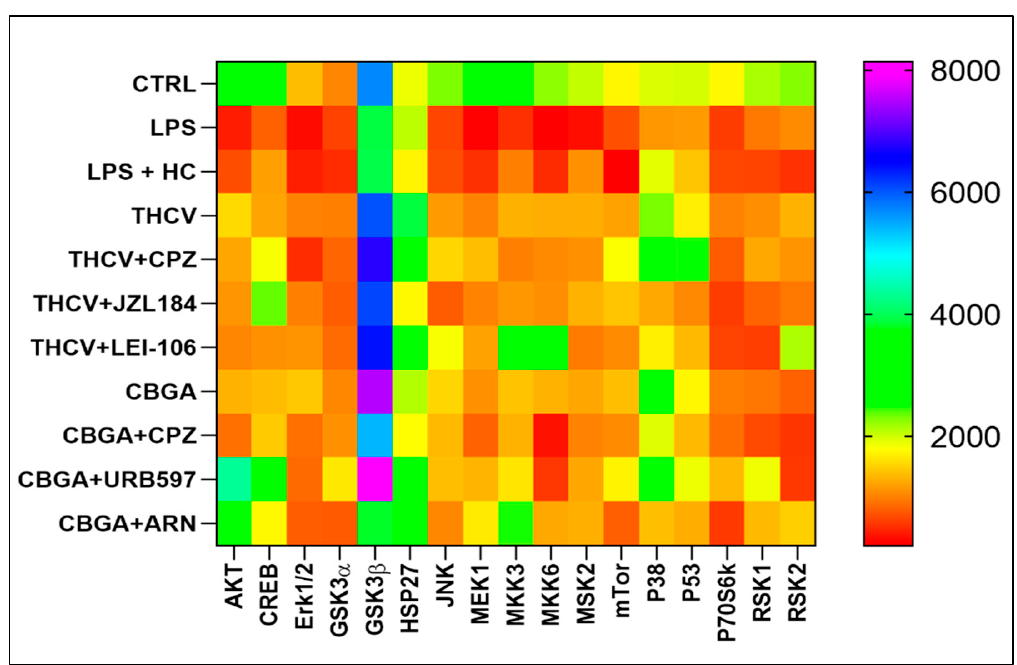
Figure 4. Heat map of the most relevant 17 proteins of the MAPK signaling pathway in HaCaT cells following 24 h treatment with LPS (5.0 μ g/mL) in the presence of pCBs (THCV (9.3 μ M) and CBGA (13.0 μ M)) and selected eCB system antagonists and inhibitors (CPZ (5.0 μ M), JZL184 (10.0 μ M), LEI ‐ 106 (10.0 μ M), URB597 (1.0 μ M) and ARN19874 (33.7 μ M)). Samples were analyzed through the Human Phosphorylation Array, and data are expressed as means of three sets of experiments for each condition ( n = 3).